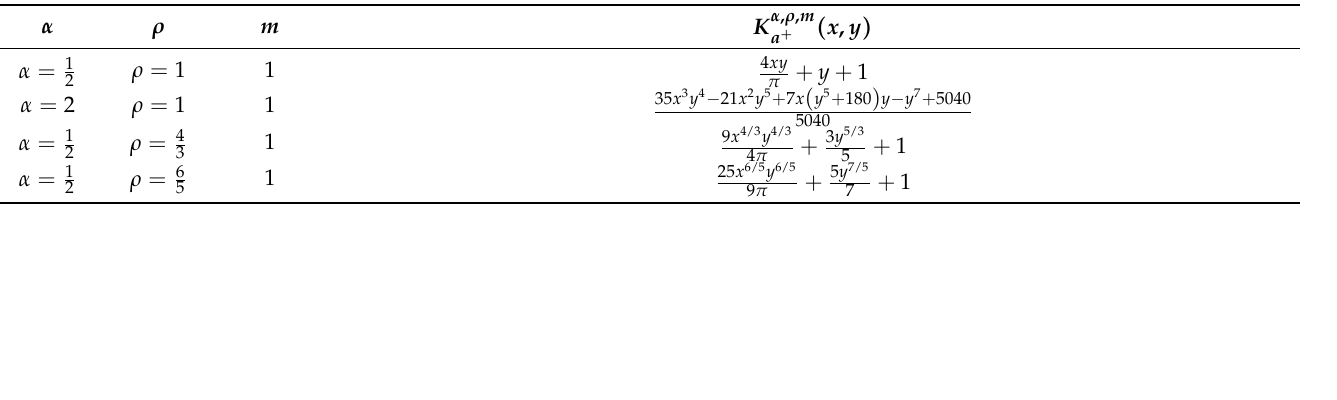
Table 1. Some new reproducing kernel functions with a = 0 and x > y